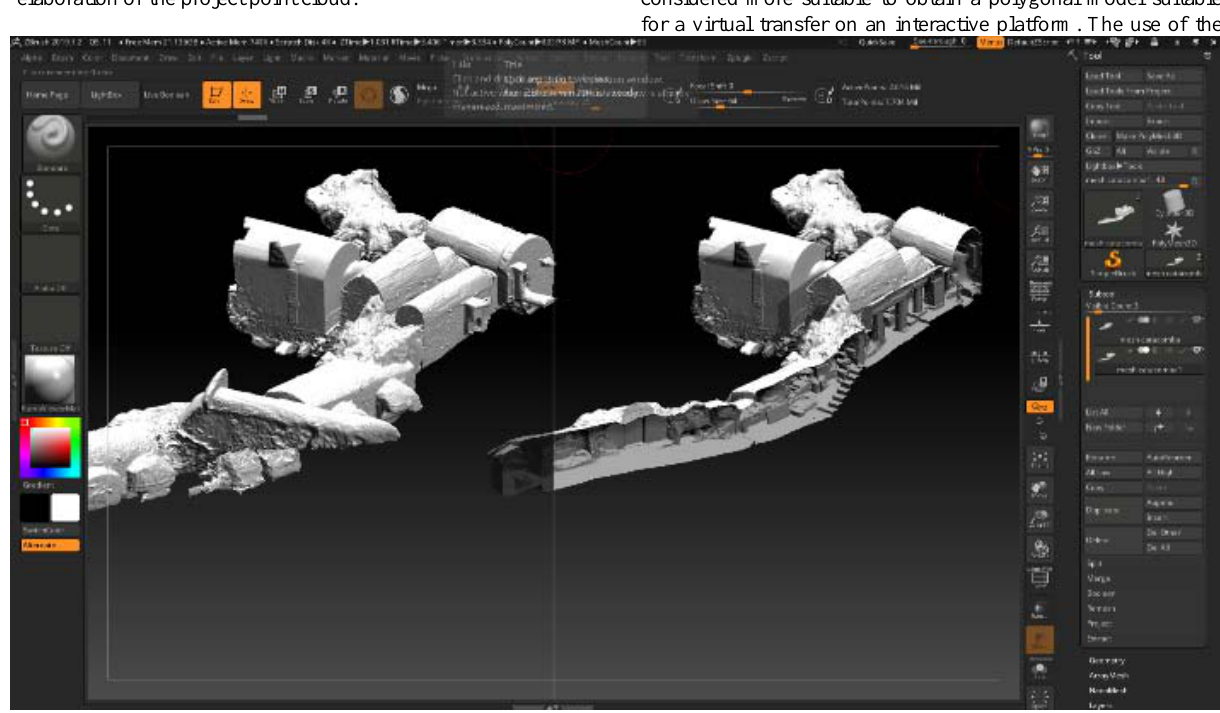
Figure 7. Optimized model of the catacombs, interactive section of a central area of the corridors using Zbrush